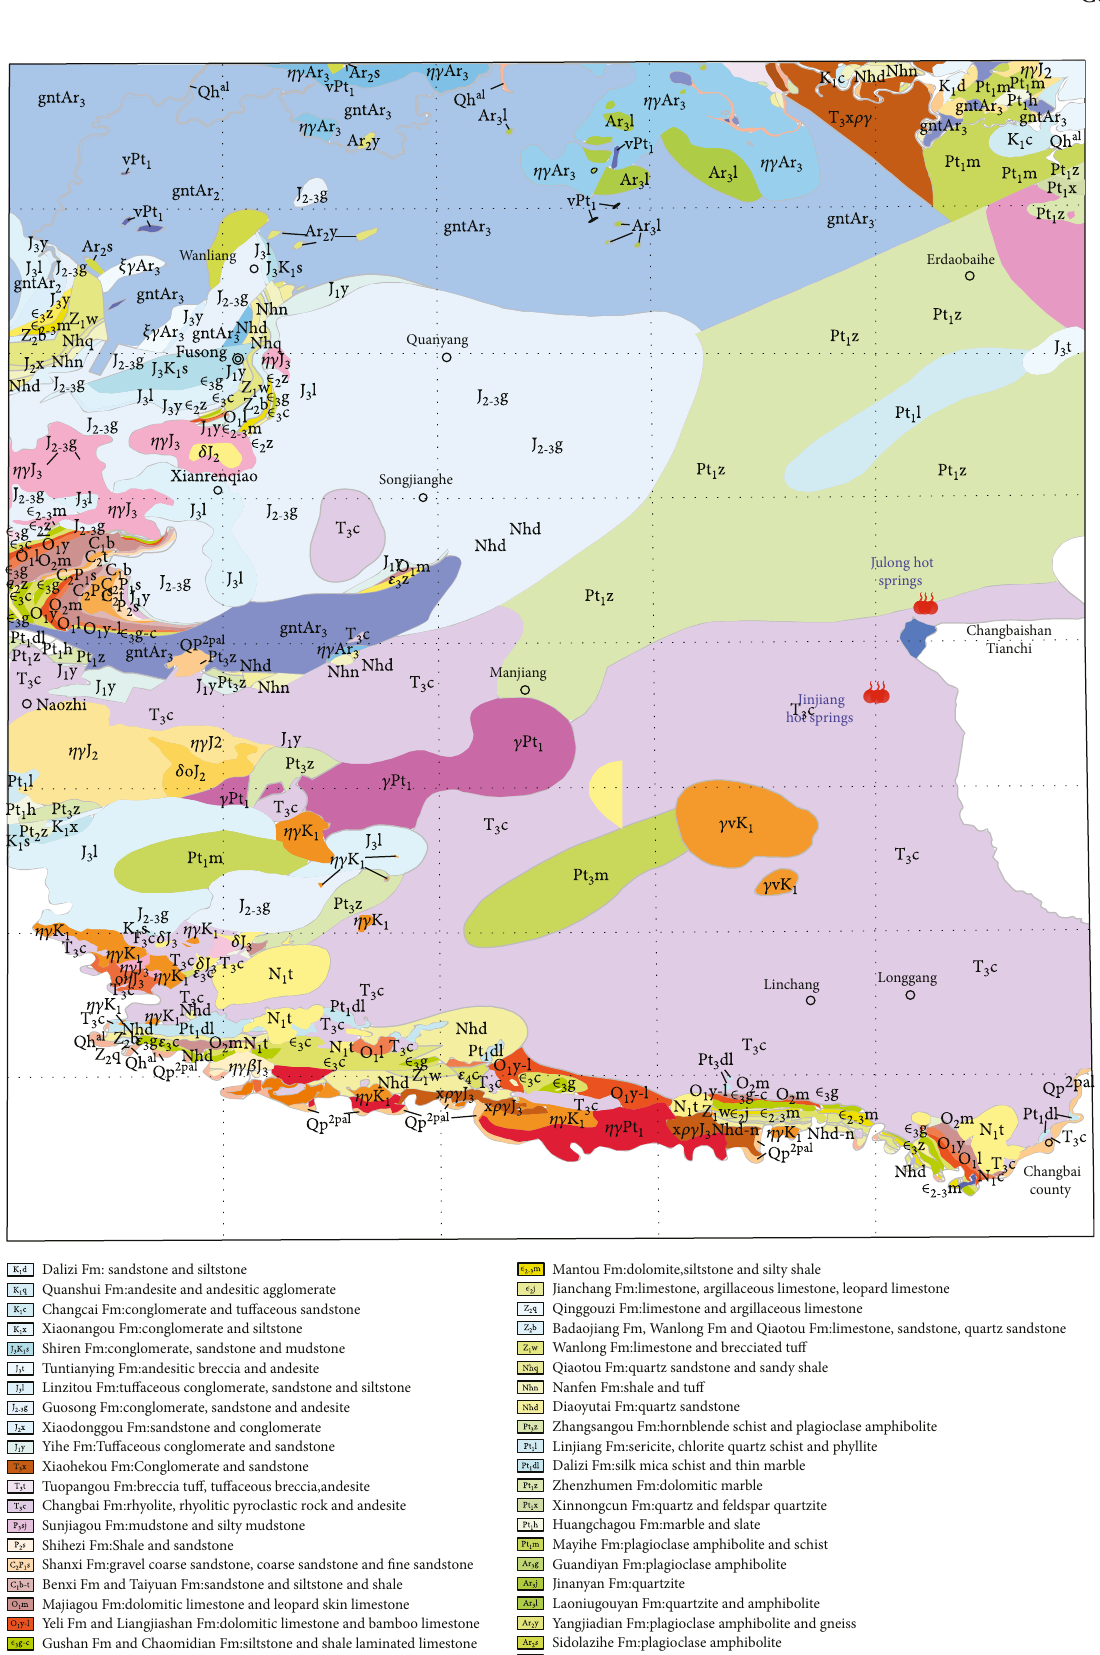
Figure 2: Bedrock geological map of the Changbai Mountain